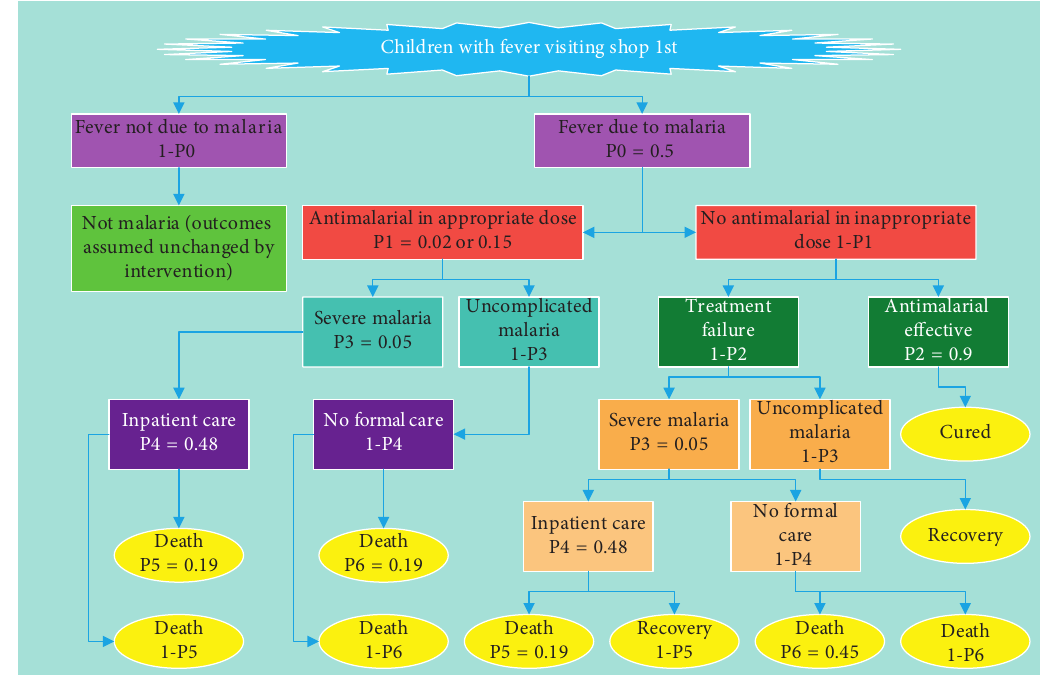
Figure 1: Improved decision tree algorithm